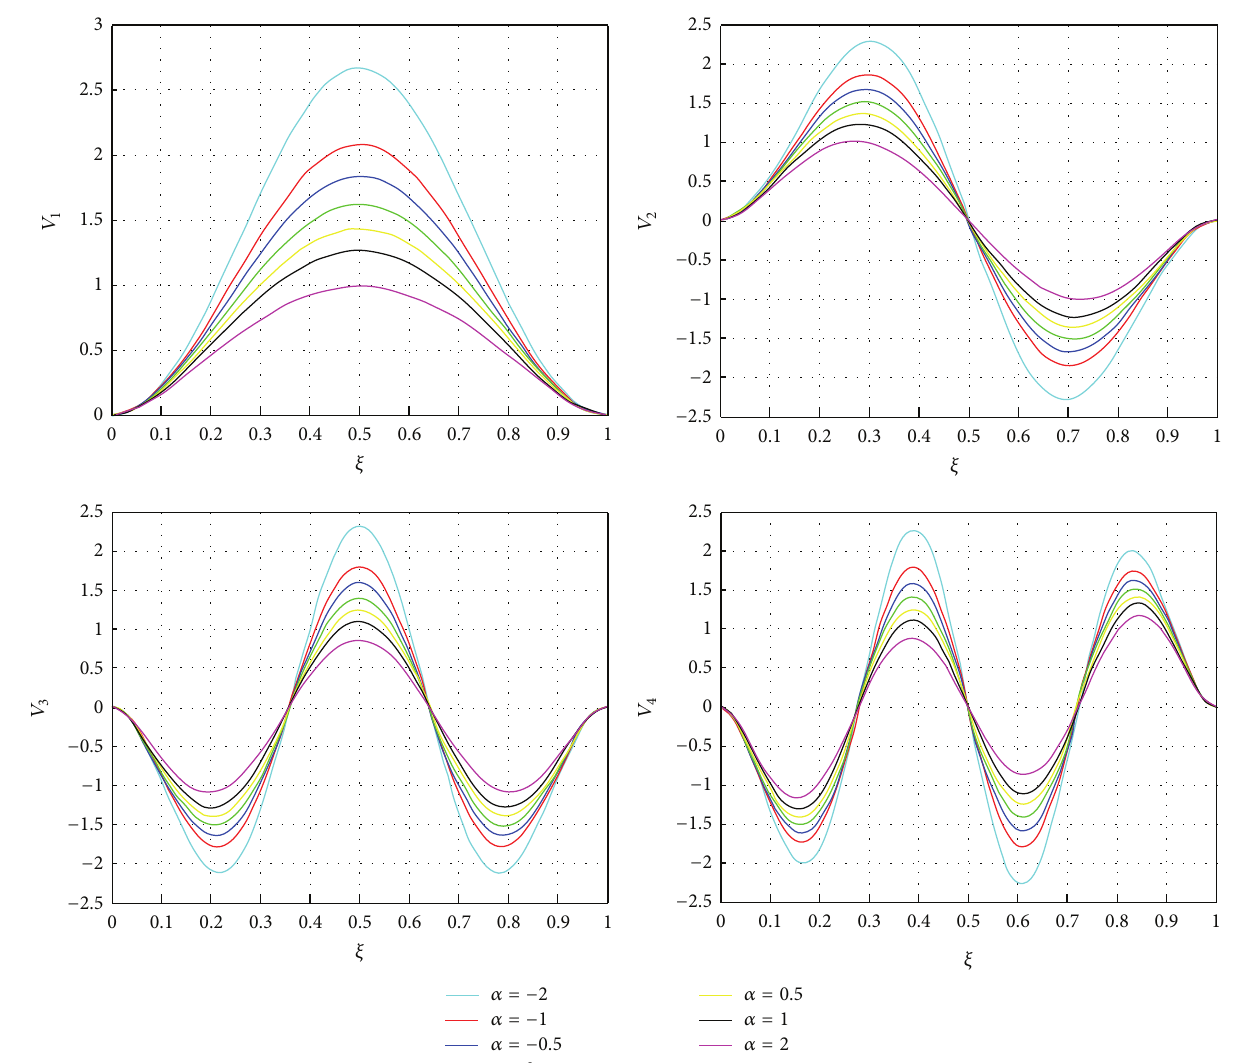
Figure 3: First four mode shapes of the linear clamped-clamped beam for different values of 𝛼